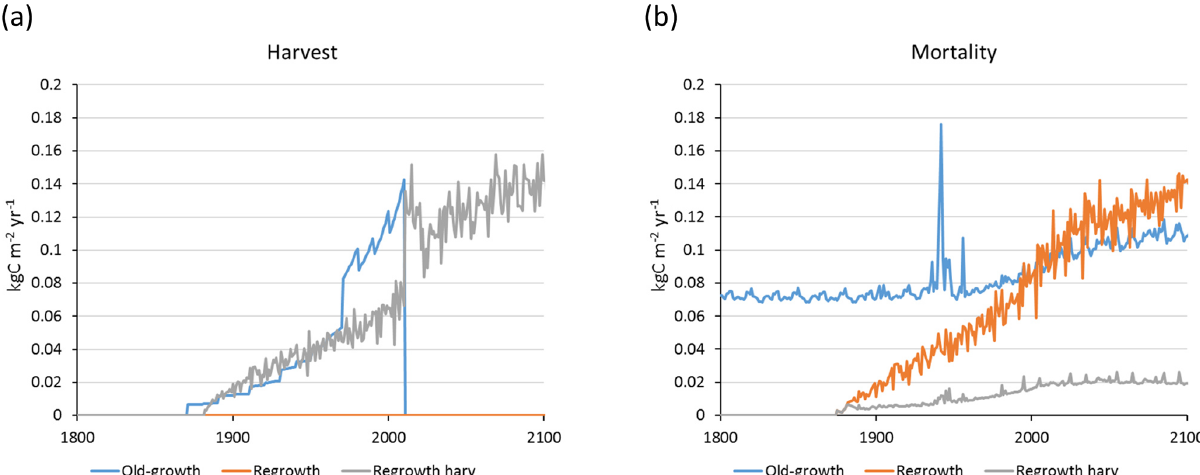
Figure E6. Simulation of European old-growth and regrowth forests with (Regrowth harv) and without (Regrowth) wood harvest in regrowth forests using historic CRU-NCEP climate, recycling the last 30 data years after 2015. (a) Harvested carbon. Old-growth harvests are clear- cuttings at the creation of secondary (regrowth) stands in the period 1870–2010. The spike in regrowth forest harvest in 2011–2020 is due to delayed clear-cutting of stands passing the tree density limit for clear-cutting before 2010. (b) Vegetation carbon lost in natural